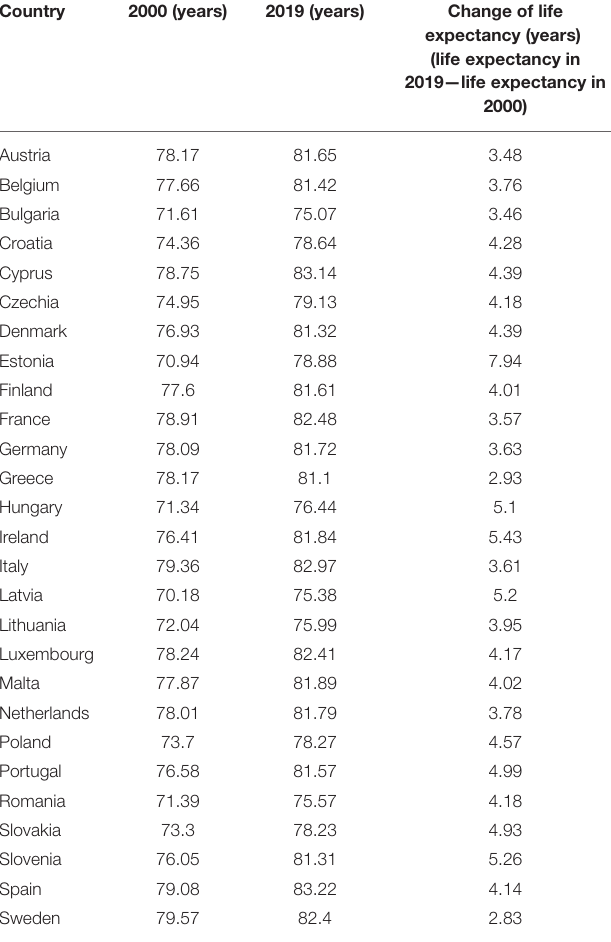
Source: World Health Organization